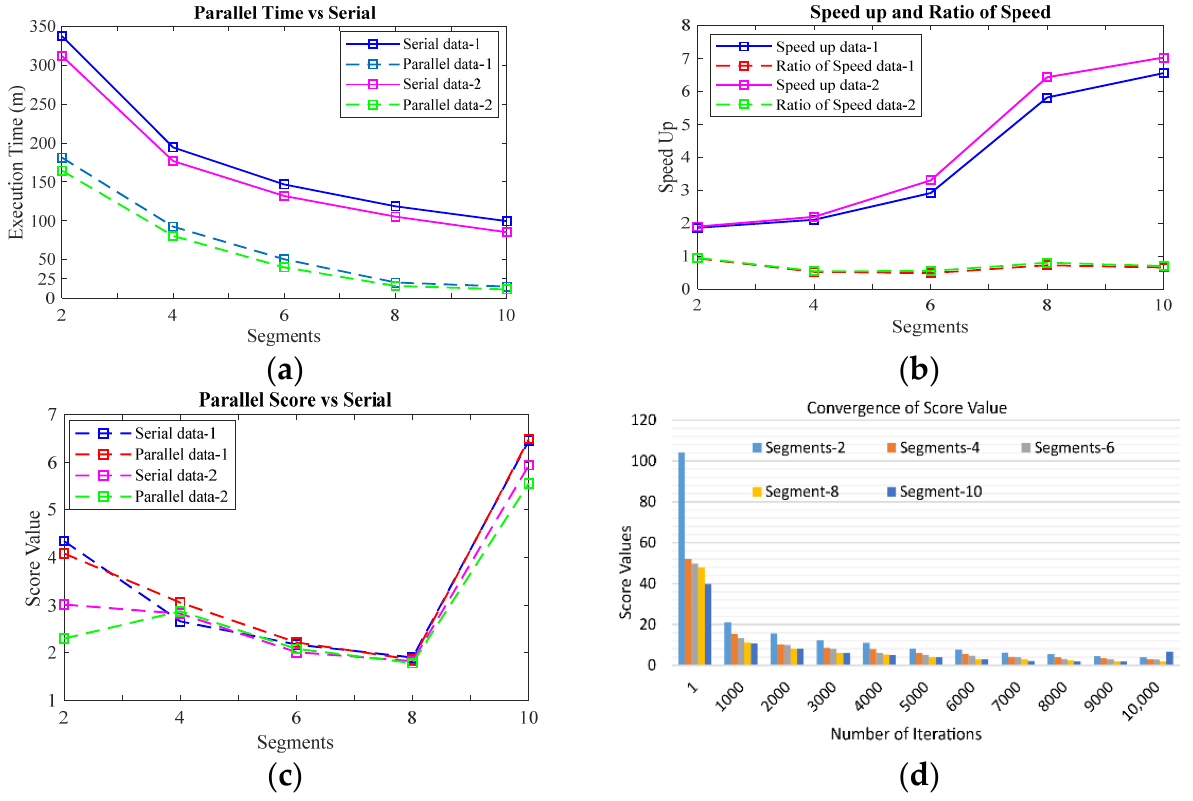
Figure 7. ( a ) Execution time of parallel vs. serial version of the algorithm; ( b ) speedup and the ratio of speed; ( c ) final score value of each segmentation with parallel and serial versions of the algorithm; ( d ) the speed of the convergence of score value of each segment in the parallel version.